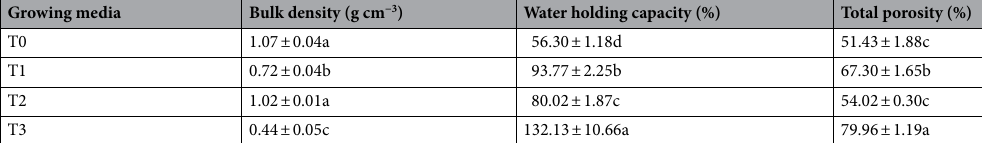
Table 2. Physical properties of the mixtures of rice husk ash and red soil with various. Proportions. T0, T1, T2, and T3 indicate the mixture of red soil to RHA at volume ratios of 1:0, 1:1, 2:1, and 1:2, respectively. The same as